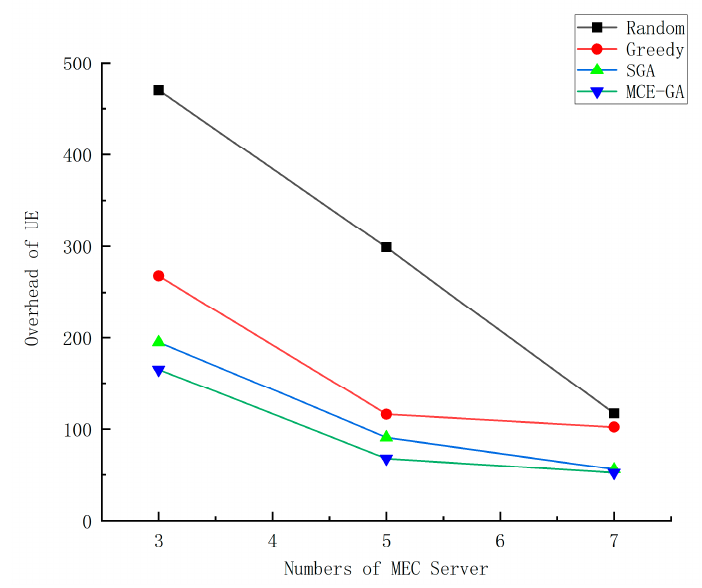
Figure 8. The execution overhead of different number of MEC server.